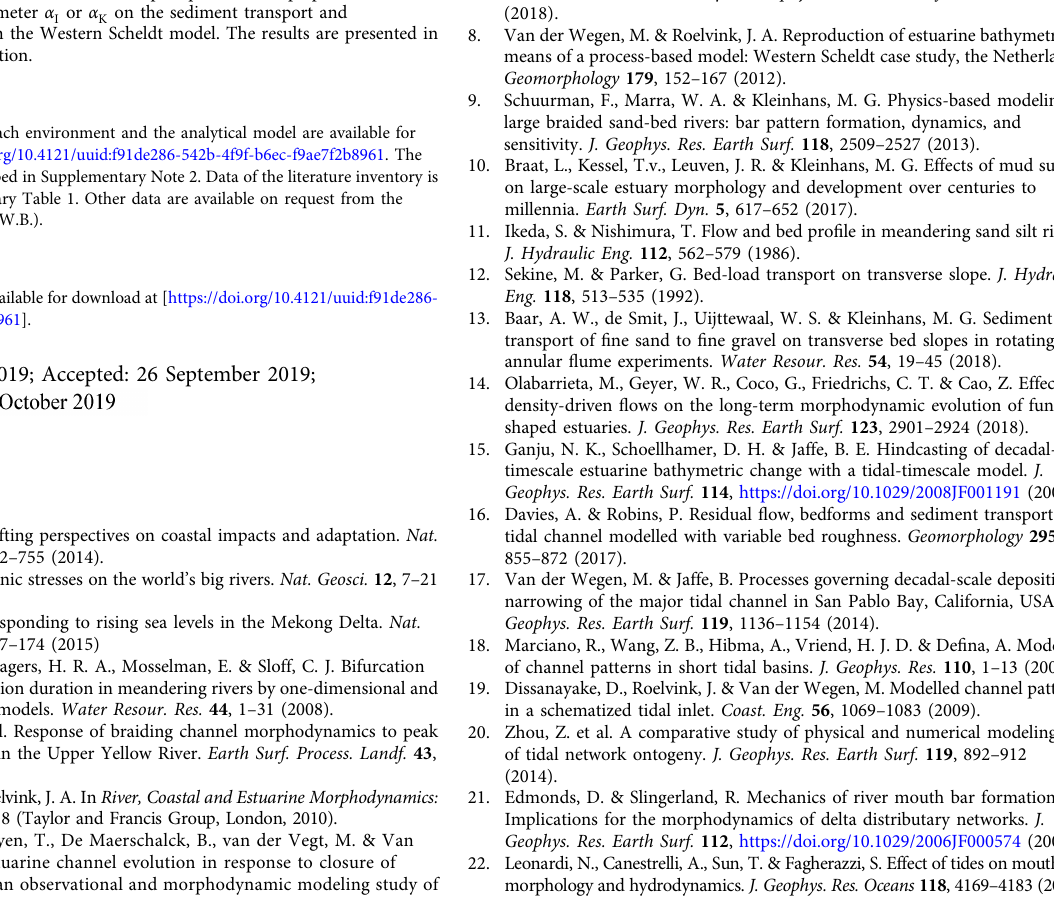
Fig. 9 Bathymetries of the tidal inlet model. Bathymetries are shown for models with the IK parameterization in combination with an α and b 25 and their corresponding binary image, where channels are black and the surrounding area is